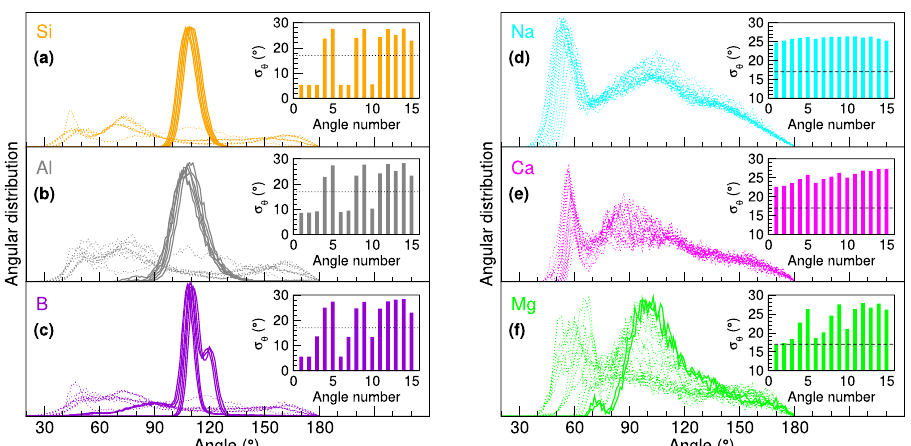
Fig. 5 Angles around the different cations, de fi ned by N = 6 fi rst neighbors, i.e., 15 possible bond angle distributions, in the N19M8 glass, with addition of calcium contribution from N19C8 as a comparison. a – f Refer to Si, Al, B, Na, Ca and Mg environment respectively. Dashed lines correspond to a large distribution of environments. Insets display the angular excursion relative to each of the 15 angles for a given element. Broken horizontal lines in the insets correspond to an approximate limit (17°) between active and broken angular constraints de fi ned based on literature 74